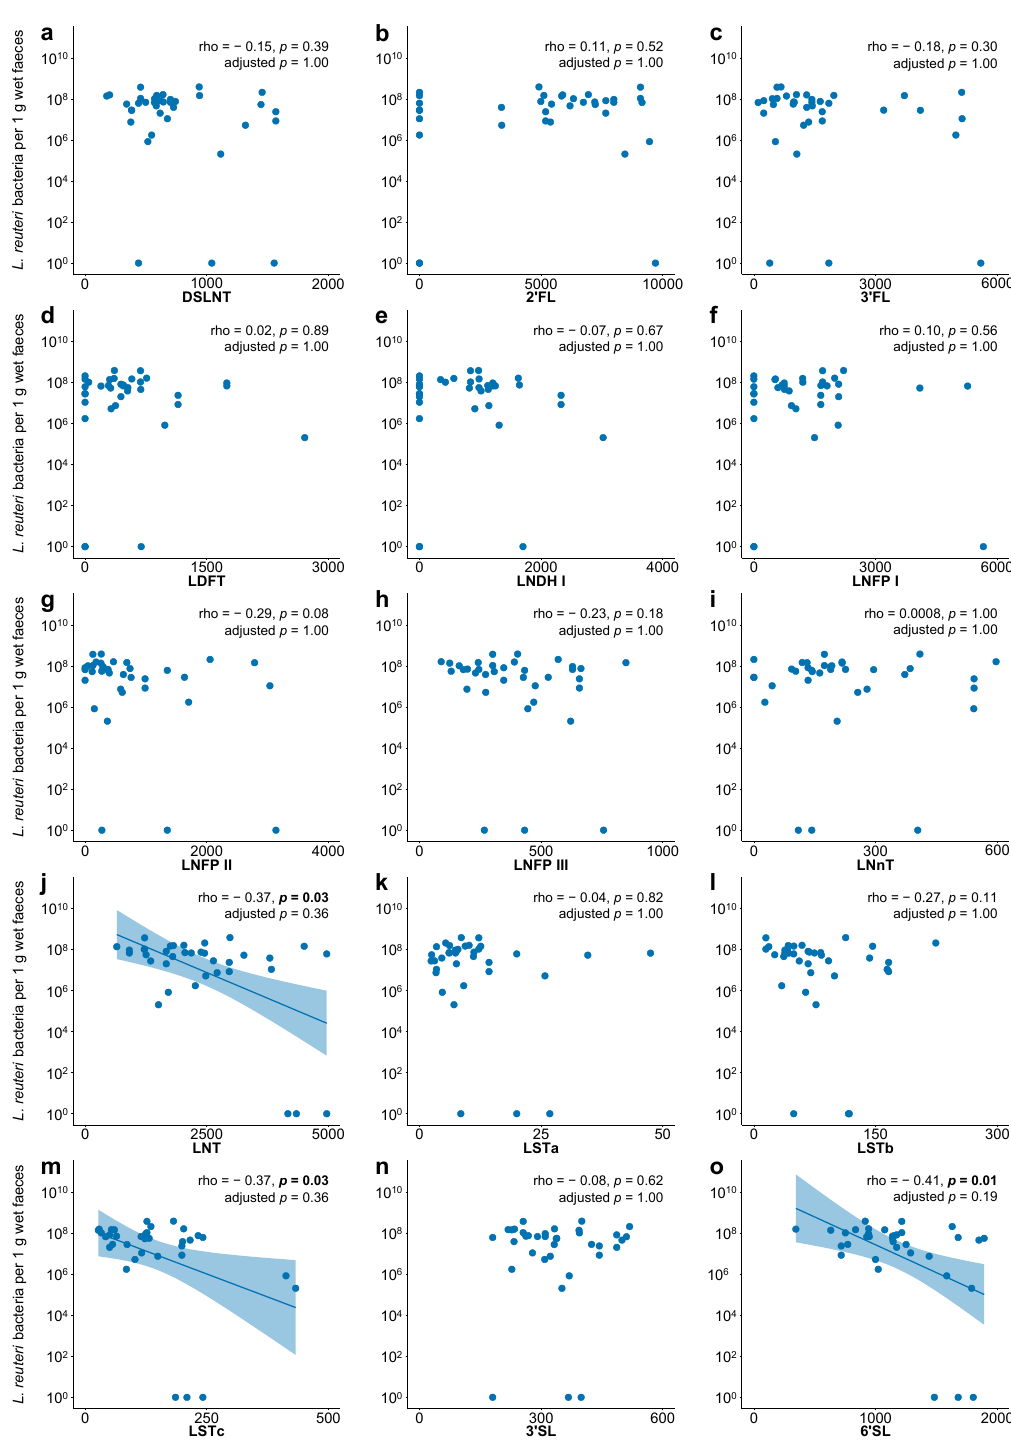
Figure 6. Human milk oligosaccharides and L. reuteri abundance in faeces of the L. reuteri -supplemented group. ( a – o ) Spearman correlation between human milk oligosaccharide concentrations ( µ mol/L) in milk collected at two weeks postpartum from exclusively breastfeeding mothers ( n = 31) and L. reuteri abundance in faeces at three weeks of age ( n = 36) from L. reuteri -supplemented infants. Abundance is shown as the number of L. reuteri bacteria per 1 g wet faeces. For